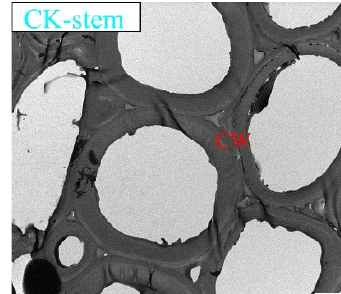
Figure 3. Distribution of Pb in different subcellular organs of K. paniculata. Note: F1 represents cell wall content fraction, F2 represents organelle content fraction, and F3 represents soluble component content fraction.